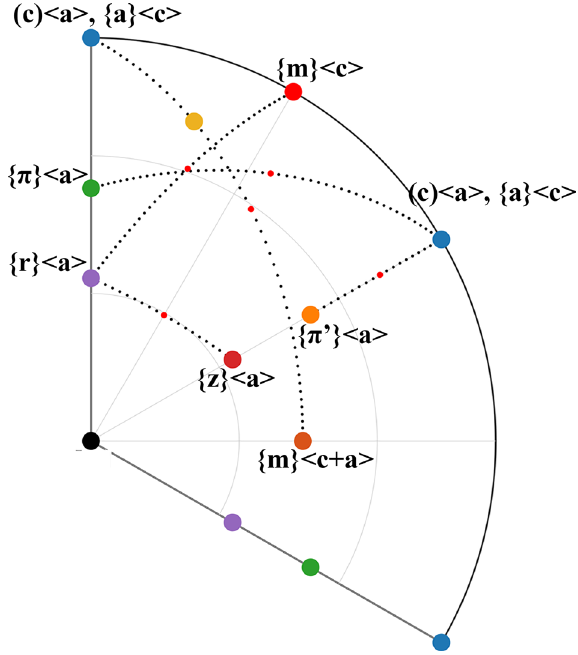
Figure 7. Quartz crystal IPF with colored directions of rotation axes characteristic for different slip systems according Table S1 in “SI”. Black dotted lines connecting two different directions correspond to calculated directions [C] that arise from a combination of rotations around these two characteristic directions. Small red dots mark the direction [C] that arises from two subsequent rotations with α = β